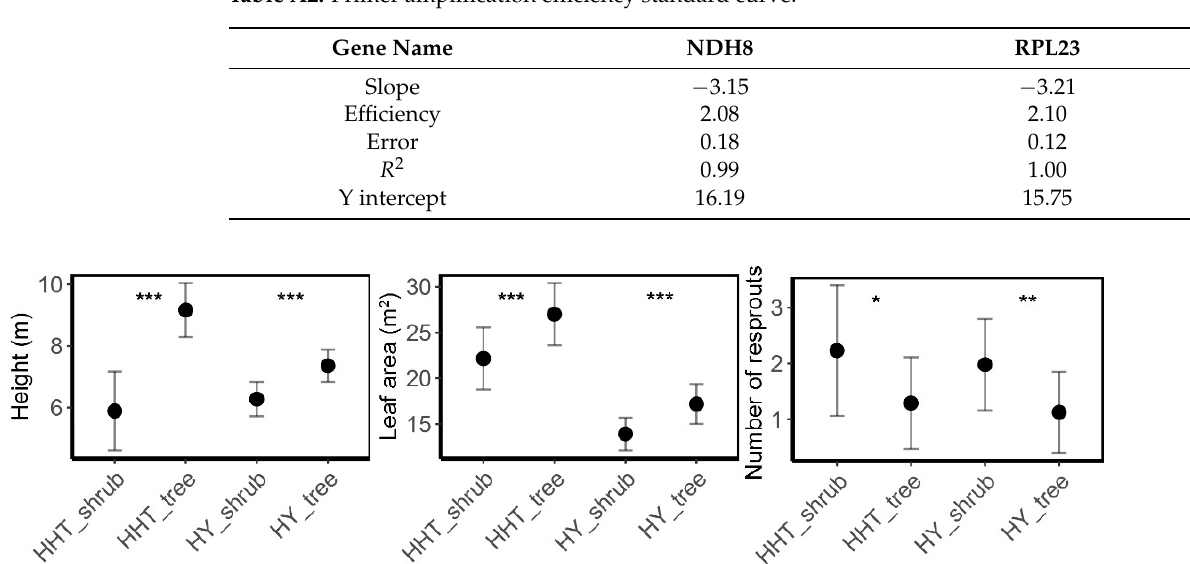
Table A2. Primer amplification efficiency standard curve.